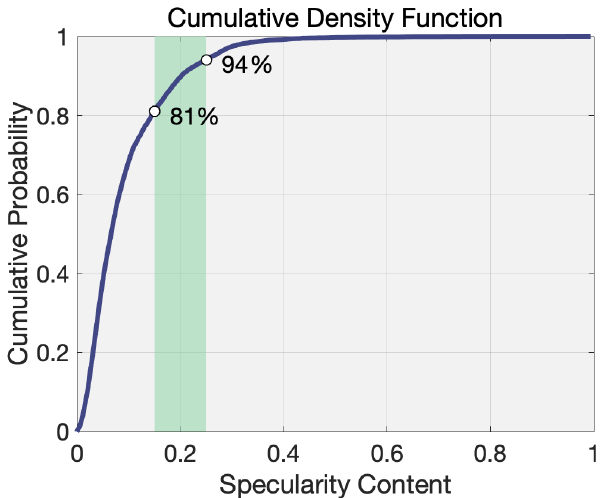
Figure B2. Cumulative density function of observed specularity data from Schroeder et al. (2013). The green band highlights the range of specularity values used to create our 11 specularity masks, which are in the 81st to 94th percentile of our